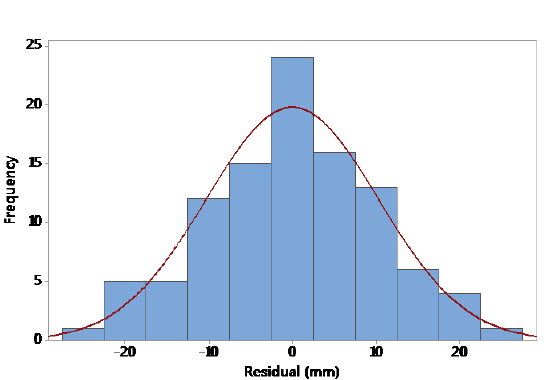
Figure 10: Histogram of the residuals superimposed with a normal distribution density function.